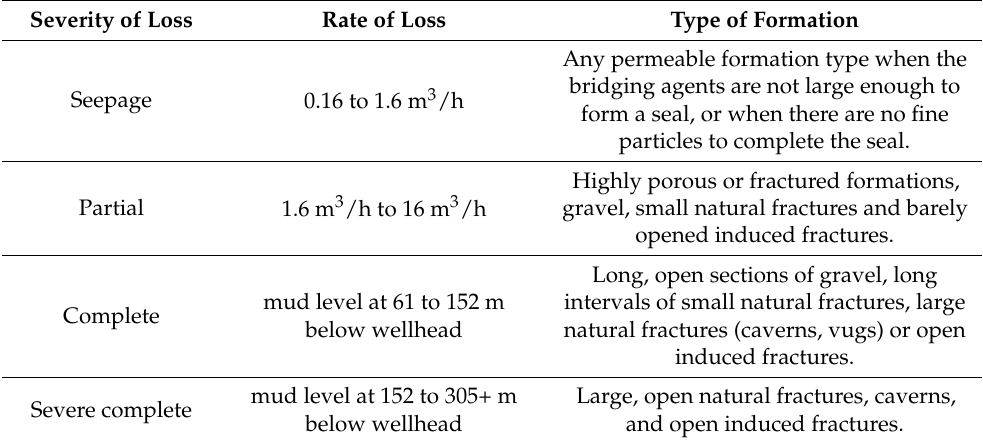
Table 2. Classification of mud loss according to its severity